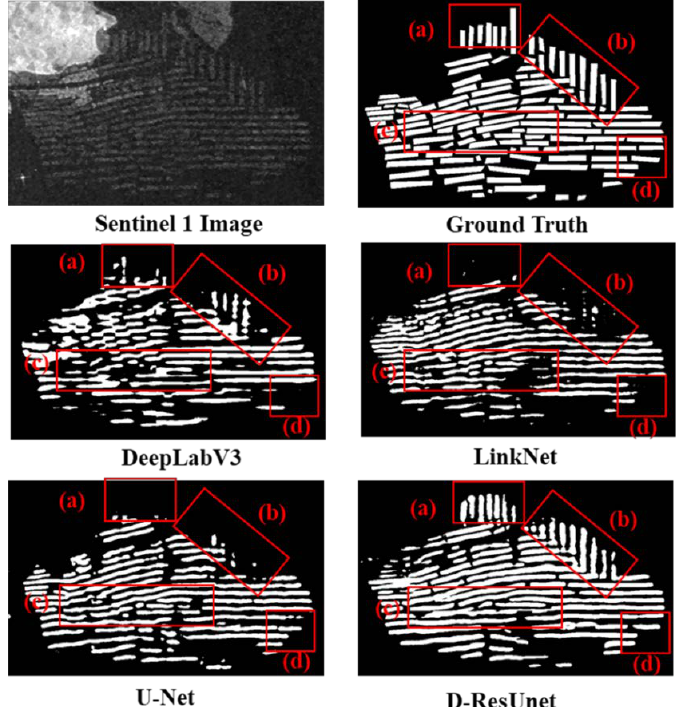
Figure 8. Resulting maps of the application experiment. Black pixels represent the seawater and white pixels represent the extracted FRA areas. Red rectangles (a–d) are areas where the FRA area is easily missed. Table 6. Precision, Recall, F1, and IoU of the models (Mean ± SD 1 ).